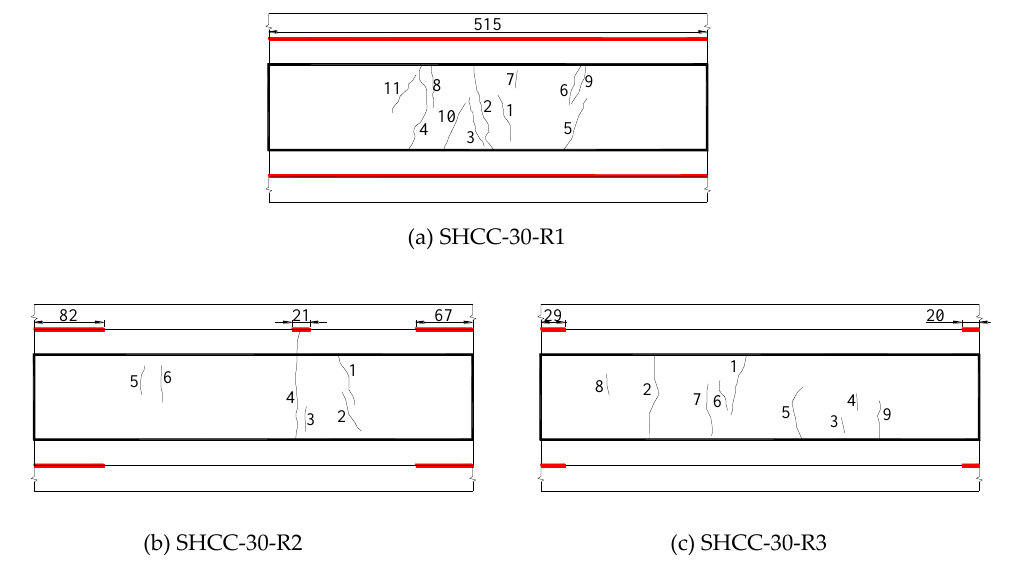
Figure 12. Influence of interface roughness on cracking and interfacial delamination patterns of SHCC repaired beams (mm).